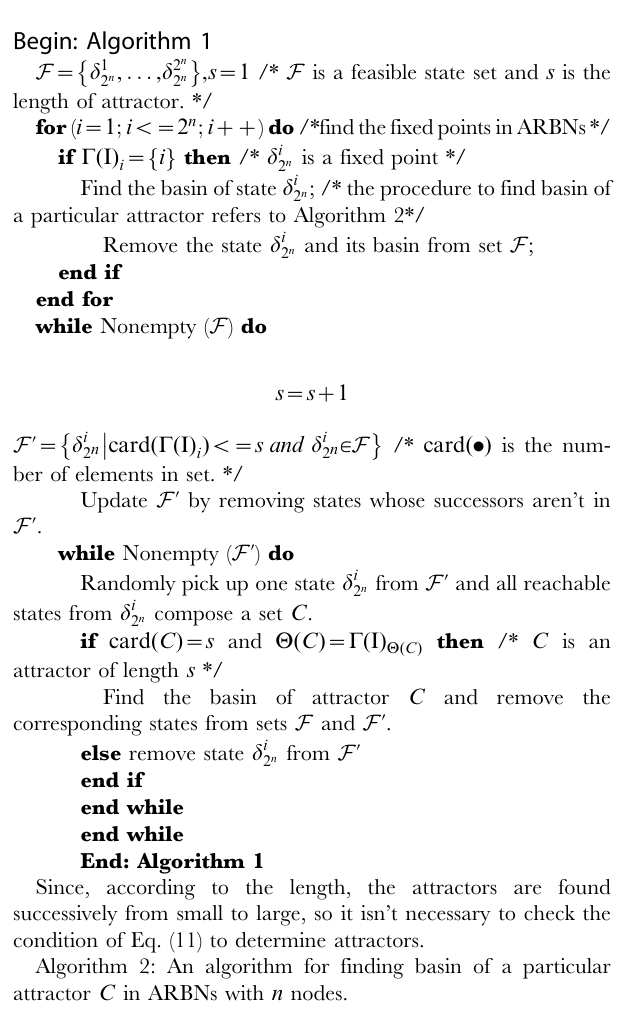
Algorithm 2: An algorithm for finding basin of a particular attractor C in ARBNs with n